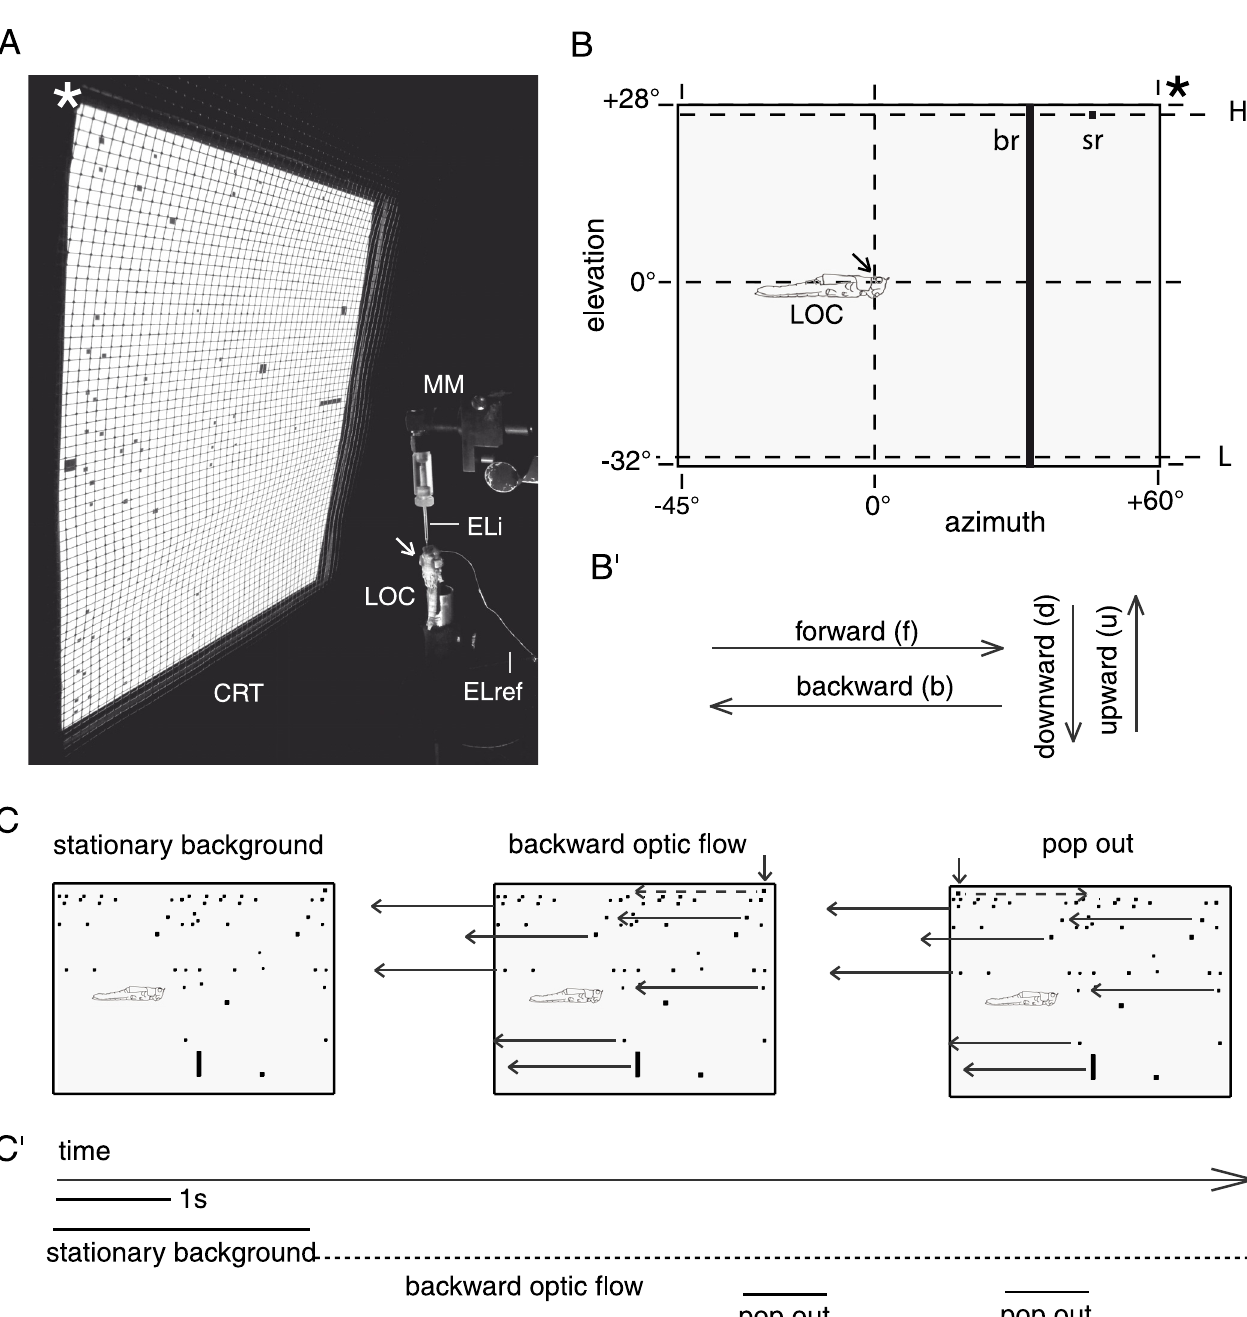
Fig 2. Experimental setup and visual stimulation. A. Experimental setup with display showing stationary background clutter. CRT, cathode ray tube display; asterisk, fronto-dorsal corner mark of CRT; MM, micromanipulator for positioning of intracellular electrode; ELi, intracellular electrode; ELref, reference electrode; LOC, locust (viewed from dorsal); arrow, stimulated (left) eye. Note the slight tilt of the CRT and the mesh wire shielding which prevented inductive interference between display and measurement circuit. B. Region in the left antero-lateral visual field covered by the stimulus display. Arrow, position of stimulated (left) eye; asterisk, fronto-dorsal corner mark of CRT; LOC, locust (viewed from lateral). Dashed horizontal lines tagged H and L indicate high- and low-elevation trajectories for translations of single small-field squares. sr, br: commonly applied square- and bar-shaped stimulus; about 2°x1.5° and 2°x60°, respectively. Albeit both types of stimulus are shown together here, they were never presented simultaneously. B'. Terminology for directions of translational motion, illustrated according to the orientation of the diagram in B. Abbreviations are given in parentheses. Forward (backward) direction of translation is abbreviated "f" ("b") and high (low) elevation is abbreviated "H" ("L"). Thus, the term "b, L" ("f, H") refers to the backward (forward) translation of a 2°x1.5° square -29.5° (+25.5°) in elevation. See S1 Fig for commonly applied sequences of such simple stimuli. C, C'. Components (C) and time course (C') of a more complex stimulus sequence designed to mimic sudden forward small-field motion against a backward optic-background flow. The